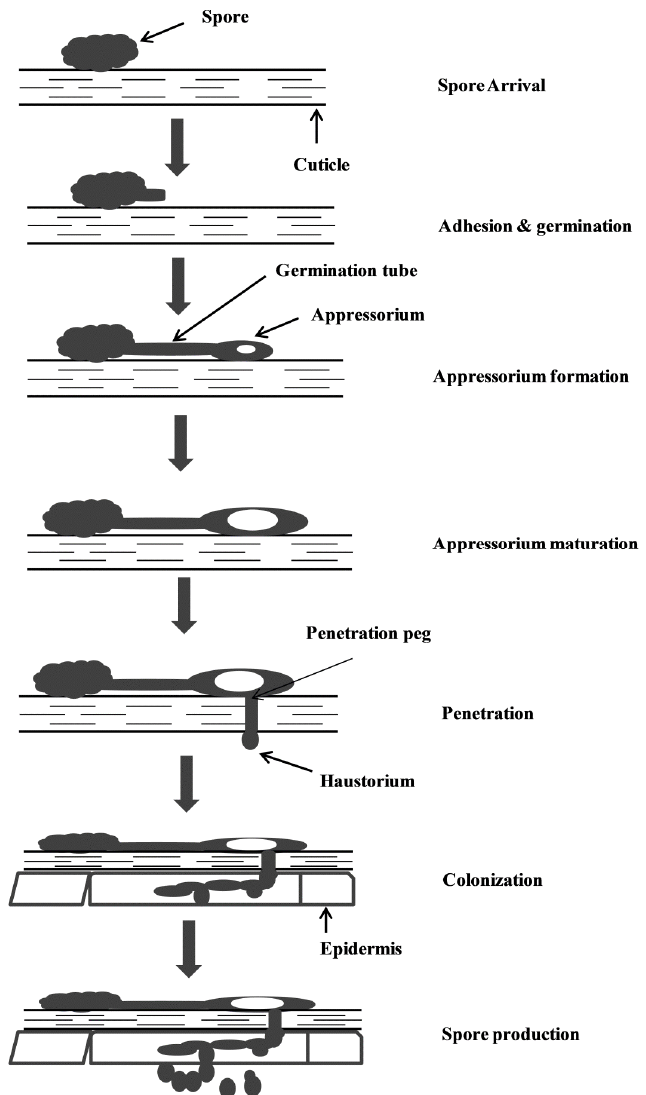
Figure 1. Process of fungal pathogenesis in plants. The figure illustrates the infection caused through am appressorium in M. oryzae . The whole process is sub-divided into four steps: formation of a pre-appressorium (spore arrival, attachment, germination, germ tube development, and differentiation into unicellular appressorium), appressorium turgor generation (appressorium maturation and synthesis of polyols), maturation (development of the appressorium pore and emergence of the penetration hypha), and penetration of the peg (effector proteins aid in plant